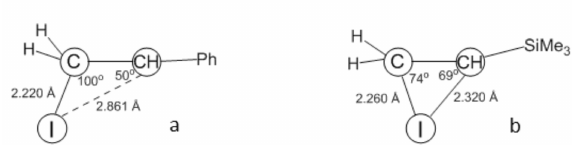
Figure 1. Linear (a) and cyclic (b) iodonium cations from electrophilic iodination of styrene 1 and trimethyl(vinyl)silane 2